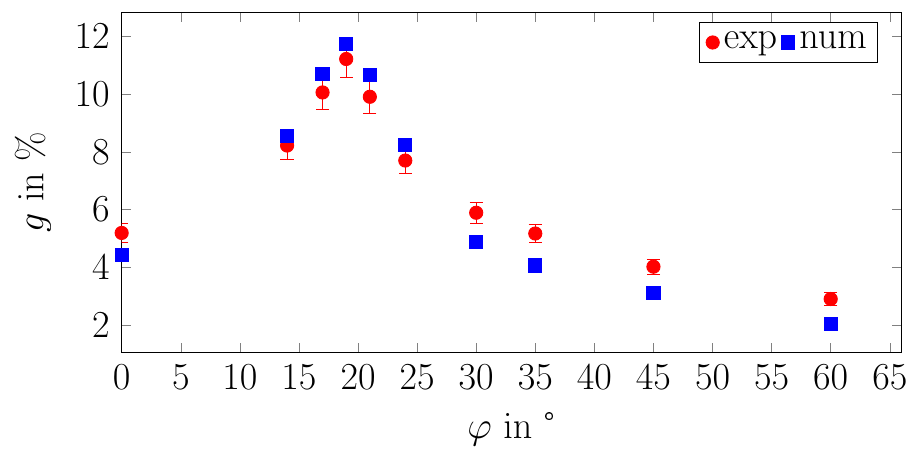
Figure 11. Experimentally (exp) and numerically (num) determined total solar energy transmittances ( g ) for the angles of incidence ( ϕ ) listed in Table